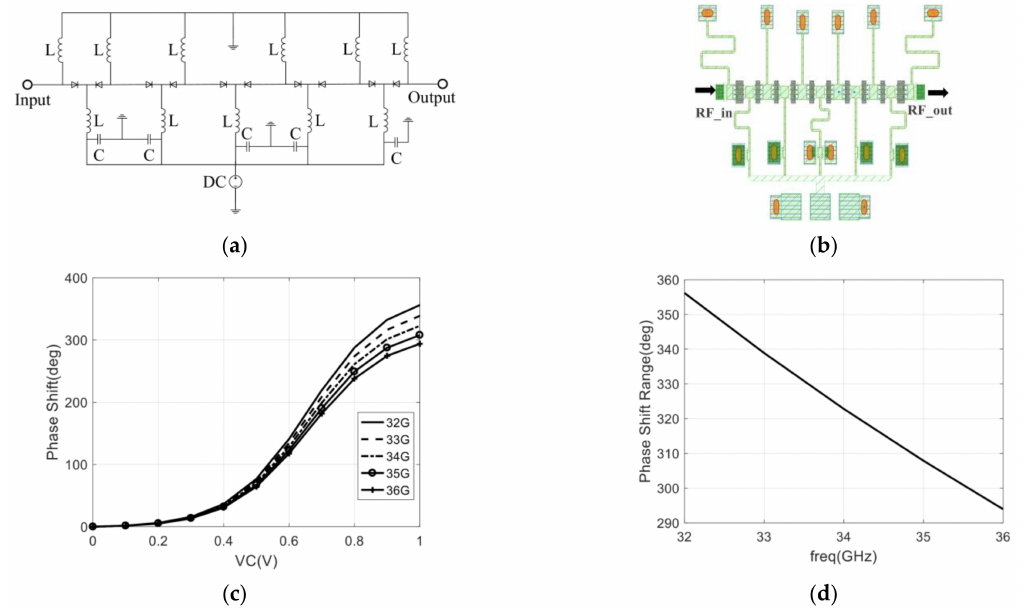
Figure 9. Phase shifter with only high-pass structure: ( a ) The schematic diagram of designed phase shifter; ( b ) The layout of designed phase shifter; ( c ) Simulation result of the phase-shifting with control voltage varying from 0 to 1 V; ( d ) Phase shift range with the control voltage is 1 V.